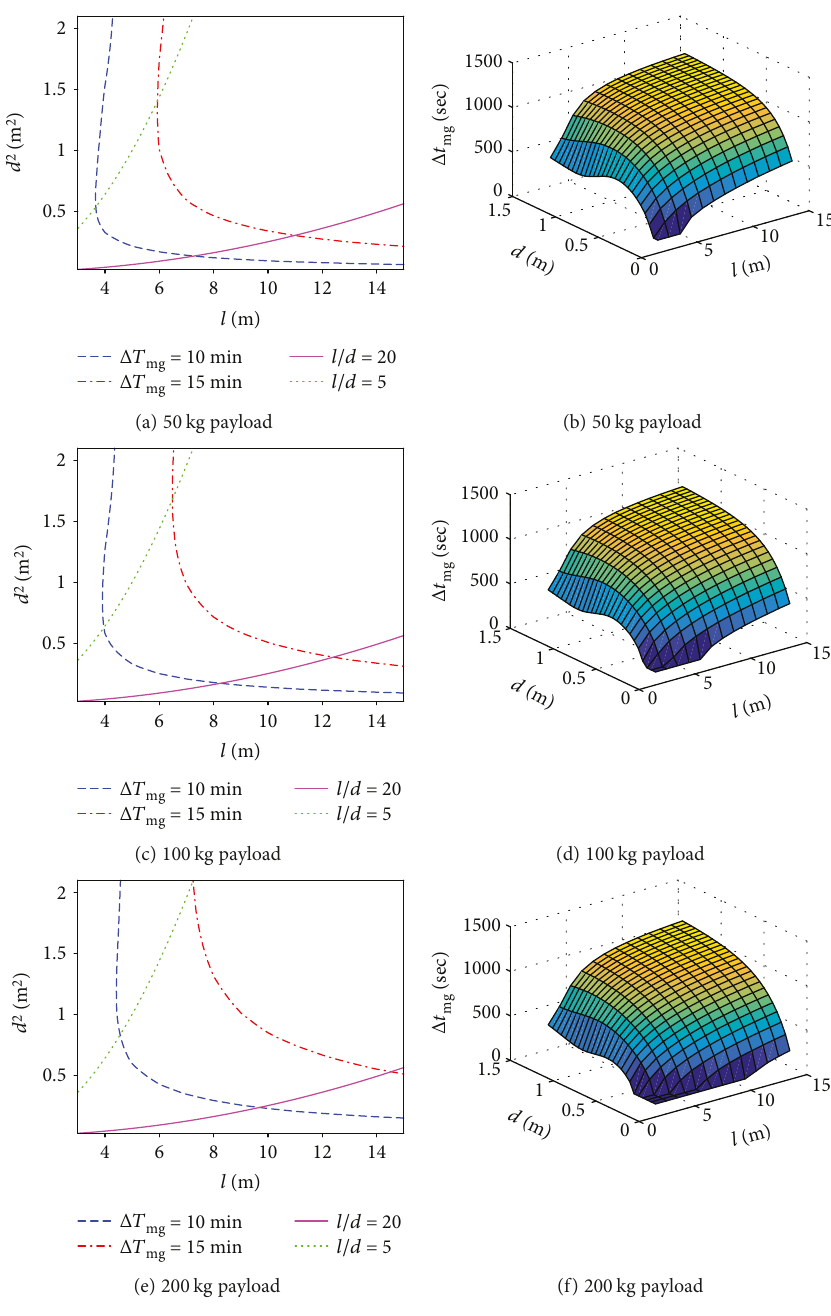
Figure 9: Optimal results for the constant attitude